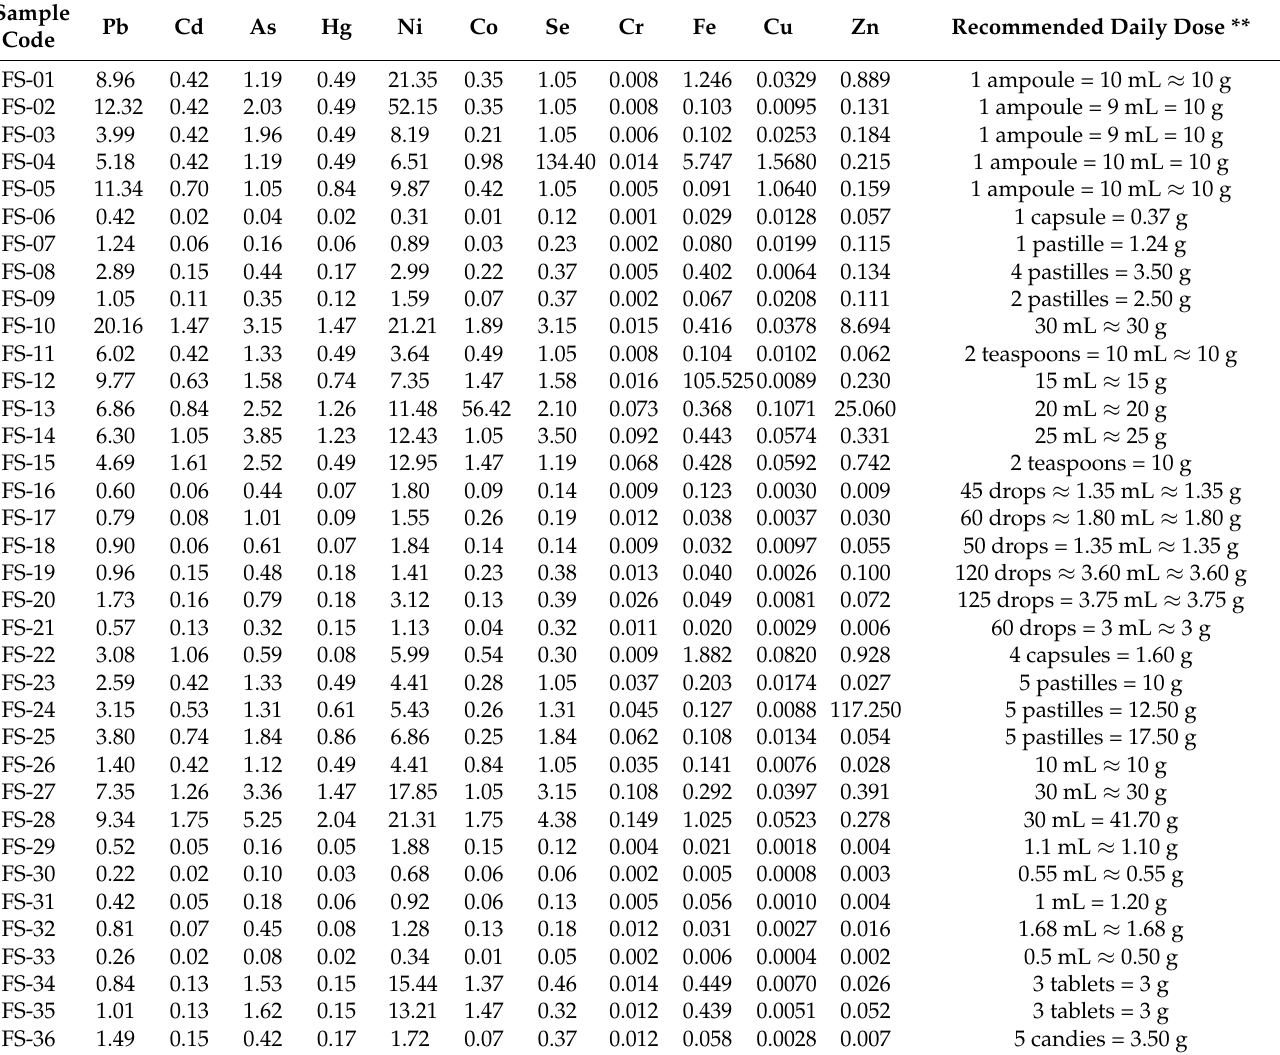
Table 4. Calculated weekly intake of toxic metals and micronutrient by average consumers for tested food supplements in view of the recommended daily dose. Pb, Cd, As, Hg, Ni, Co and Se are expressed in µ g per week while Cr, Fe, Cu and Zn were expressed in mg per